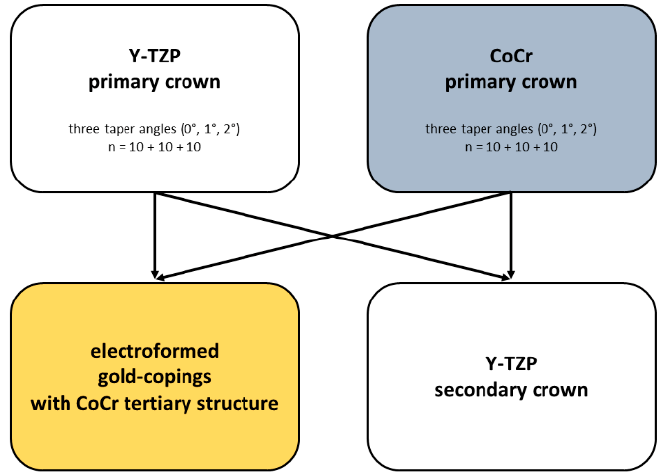
Figure 1. Treatment groups and combination of the telescopic crown assemblies.